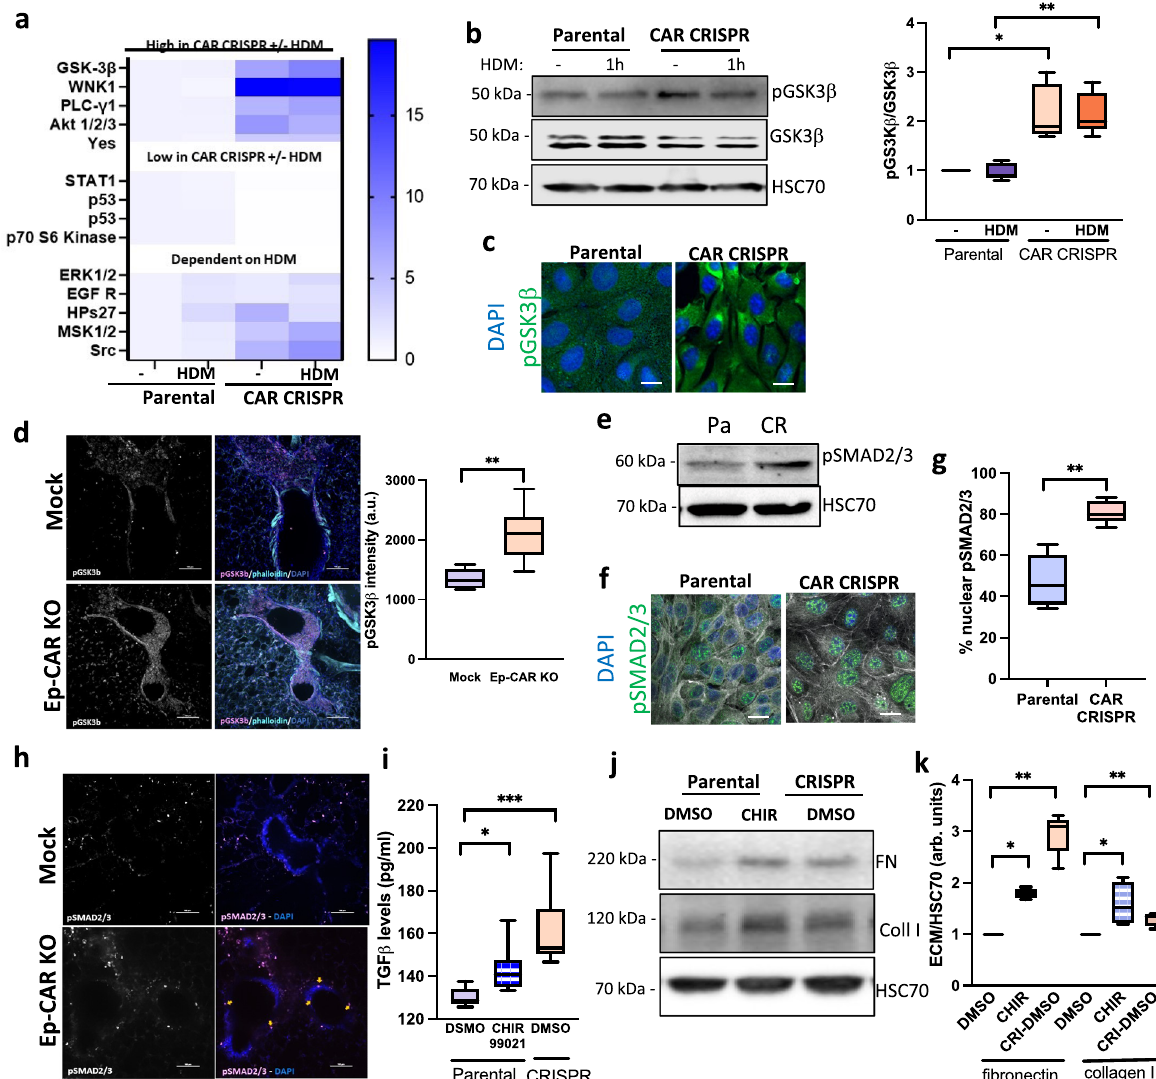
Fig.8|CARcontrolsaGSK3 β -TGF- β signallingaxisinlungepithelium.a Lysates from parental and CAR CRISPR 16HBE cells±HDM subjected to analysis using the HumanPhospho-KinaseArray.Phosphorylationfoldchangesoftargetproteinsare indicatedaccordingtoscalebar. b Representativewesternblotoflysatesfromcells as in a probed for pGSK3 β , GSK3 β and HSC70. Quanti fi cation from three inde- pendent experiments is shown. c Confocal images of parental and CAR CRISPR 16HBE cells stained for pGSK3 β (green) and DAPI (blue). Scale bars: 10mm. d Representative confocal Z-projection of PCLS from Mock or Ep-CAR KO mice, fi xed and stained for pGSK3b (magenta), F-actin (cyan) and DAPI (blue). Scale bar: 100mm. Graph to right shows quanti fi cation of pGSK3b from 30 different airways pooled from 5 mice per condition (1 PCLS/mouse) and representative of 3 inde- pendentexperiments. e LysatesfromparentalandCARCRISPR16HBEcellsprobed for pSMAD2/3 and HSC70. f Confocal images of parental and CAR CRISPR 16HBE cells stained for pSMAD2/3 (green) and DAPI (blue); F-actin is shown in